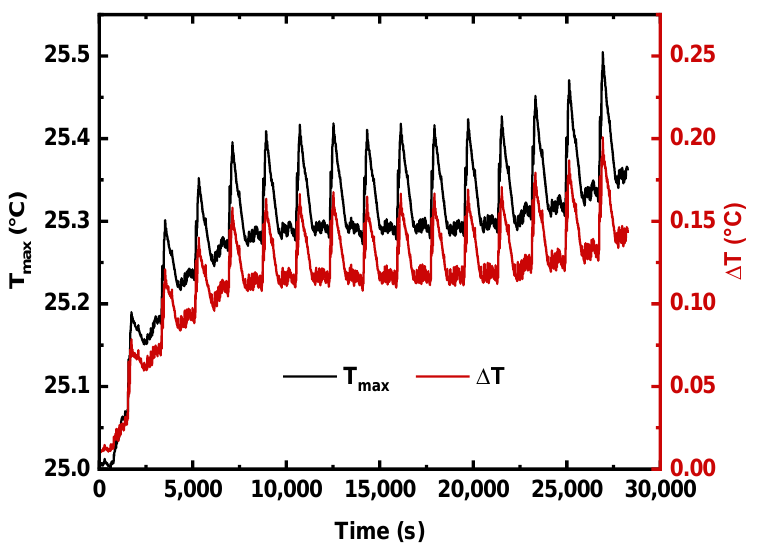
Figure 15. Variation in maximum temperature and maximum temperature difference of the battery module with BTMS during 15.7 WLTCs.